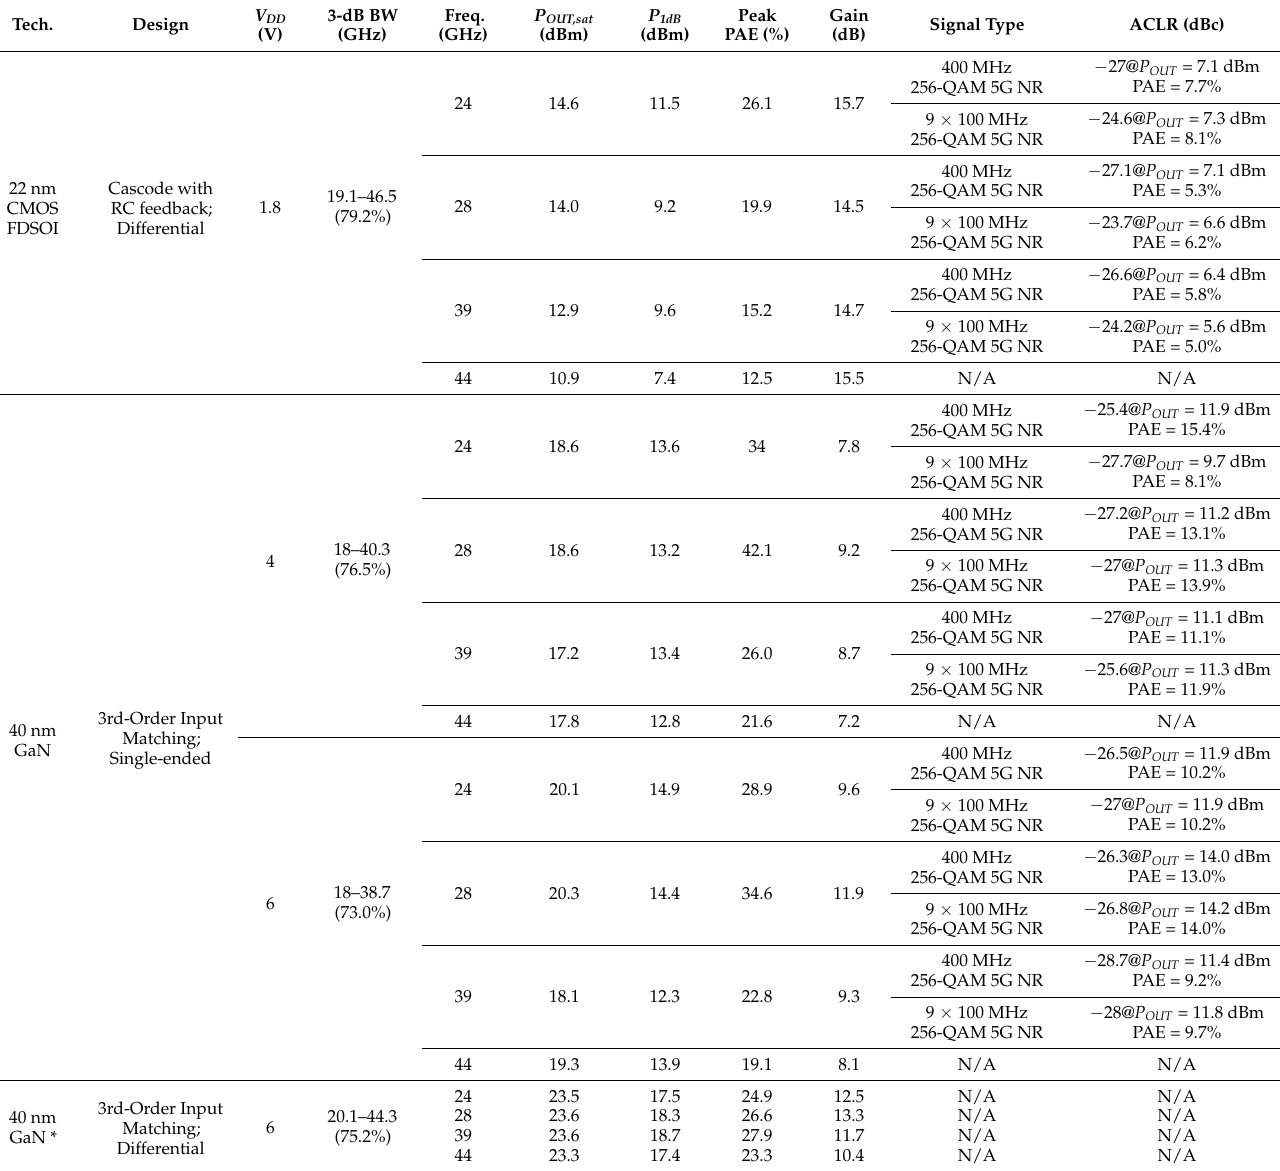
Table 1. Comparison of the three Broadband mm-Wave PAs presented in this